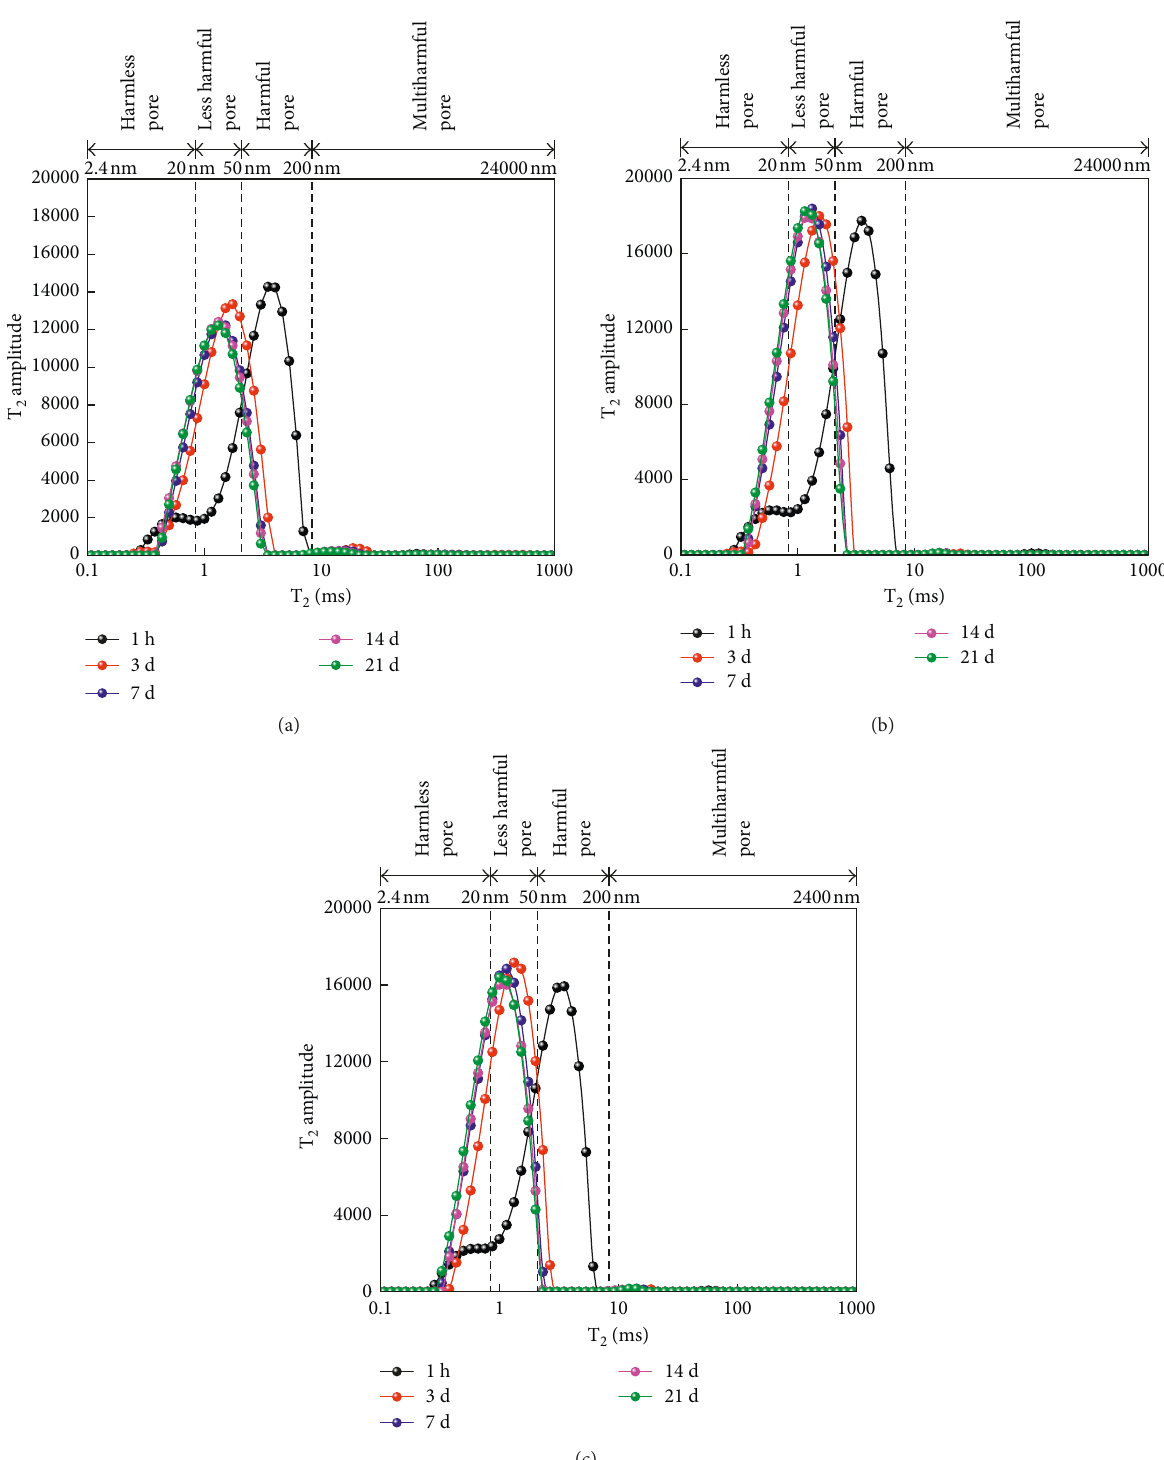
Figure 4: The T 2 curve and pore size distributions of the filling slurries with different concentrations: (a) 56%, (b) 62%, and (c)